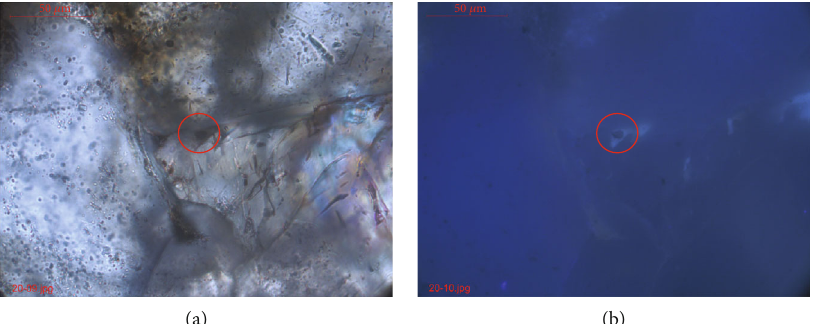
Figure 8: Photomicrograph of two-phase fl uid inclusions in ankerite cement from the Es fl uorescent light